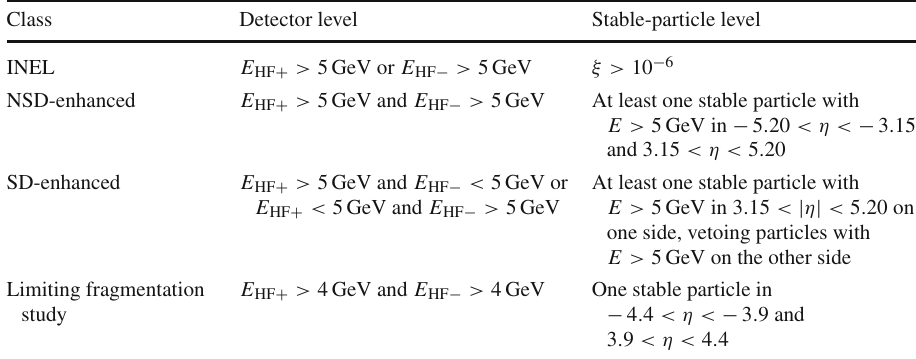
Table 1 Summary of the event selections used for the different event categories in data at the detector level and in simulations at the stable-particle level